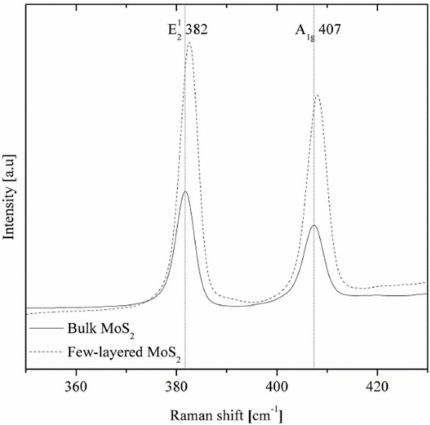
Figure 2. Raman spectroscopy of bulk and few-layered MoS 2 .